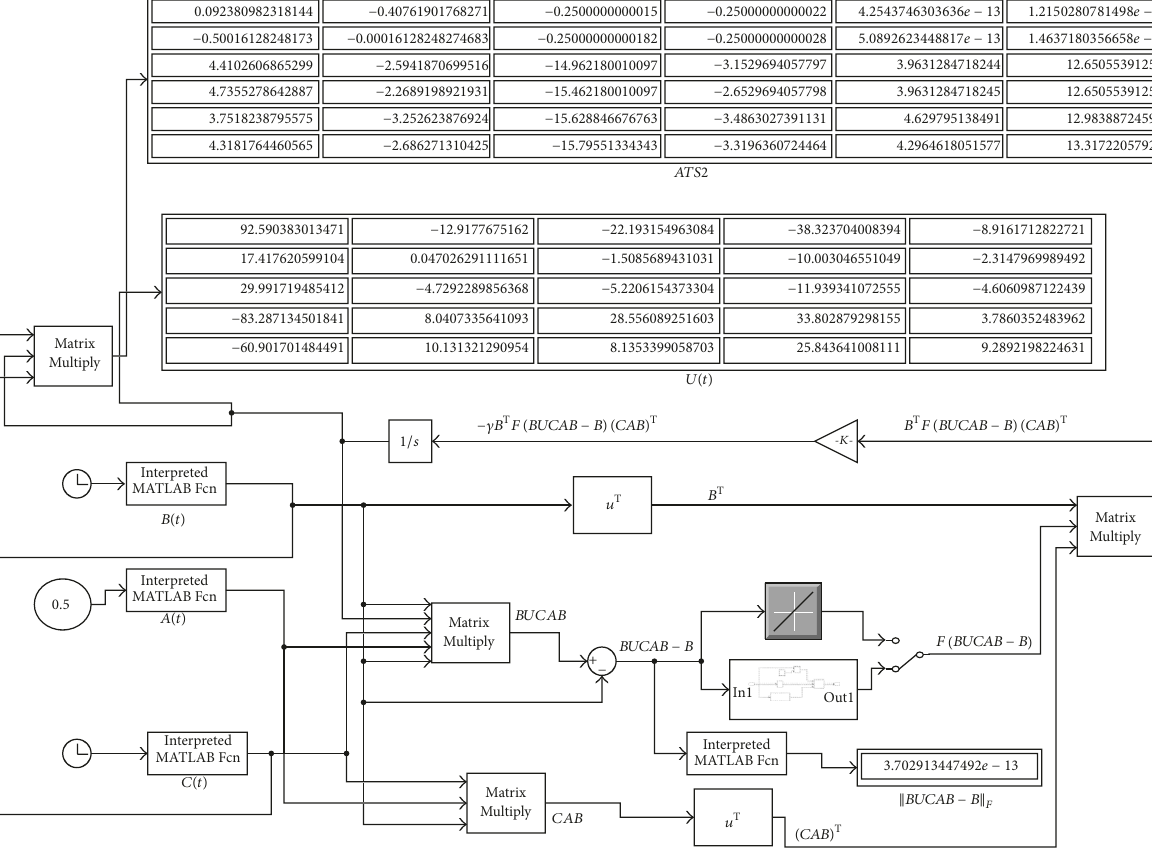
Figure 9: Simulink implementation of Algorithm